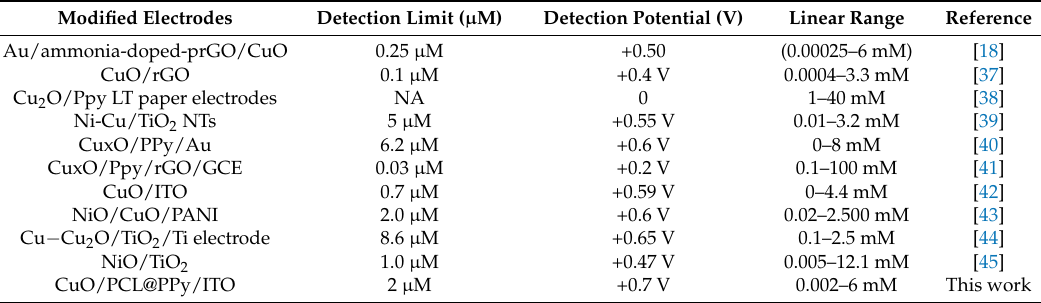
Table 2. A comparison of the CuO/PCL@PPy/ITO electrode with other